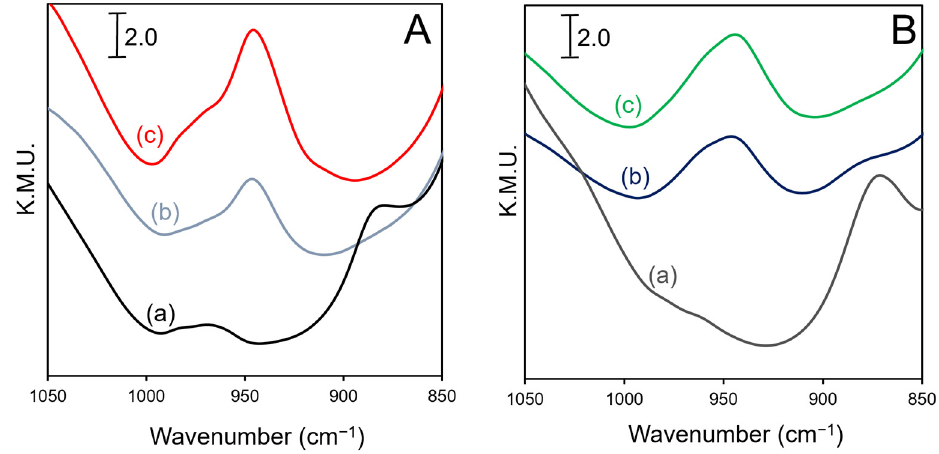
Figure 5. T-O-T DRIFT spectra of catalysts after in situ pretreatment at 350 °C. ( A ) (a) H-Beta, (b) Ni-H-Beta (H + -1x), (c) Ni-H-Beta (H + -4x); ( B ) (a) NH 4 -Beta, (b) Ni-NH 4 -Beta, (c) Ni-H-Beta (NH 4+ -4x).